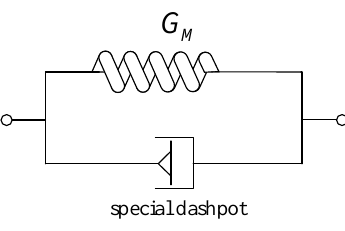
Figure 3: Mechanical analogy diagram of Model 2